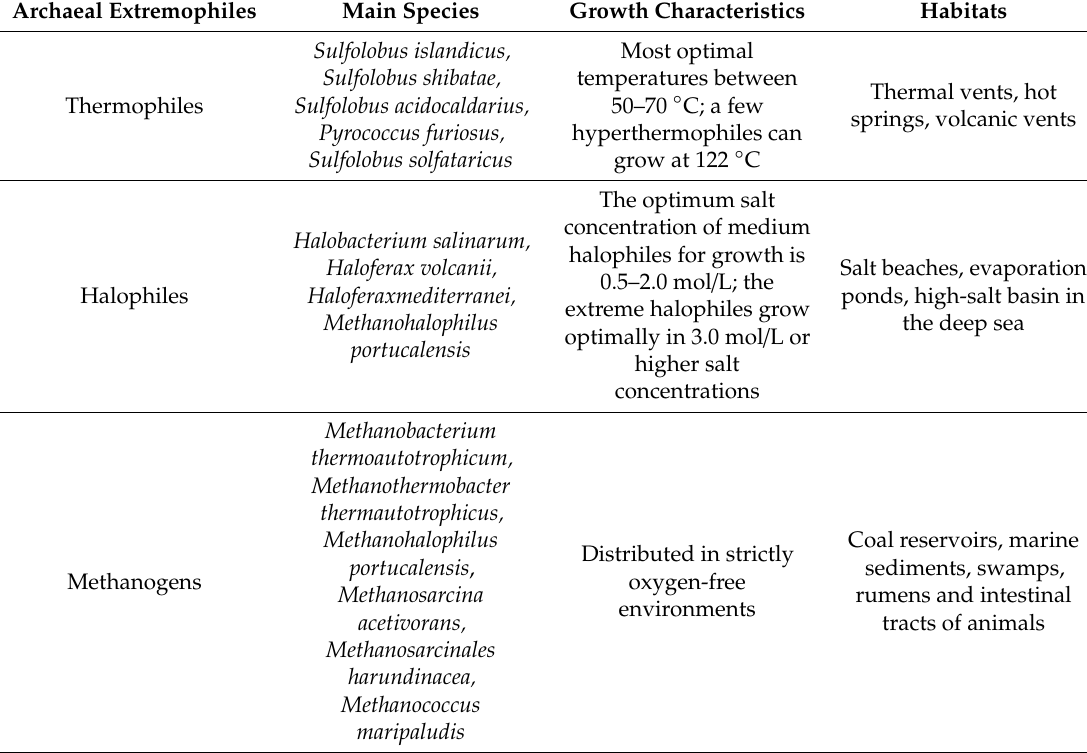
Table 1. Growth characteristics of archaeal extremophiles discussed in this